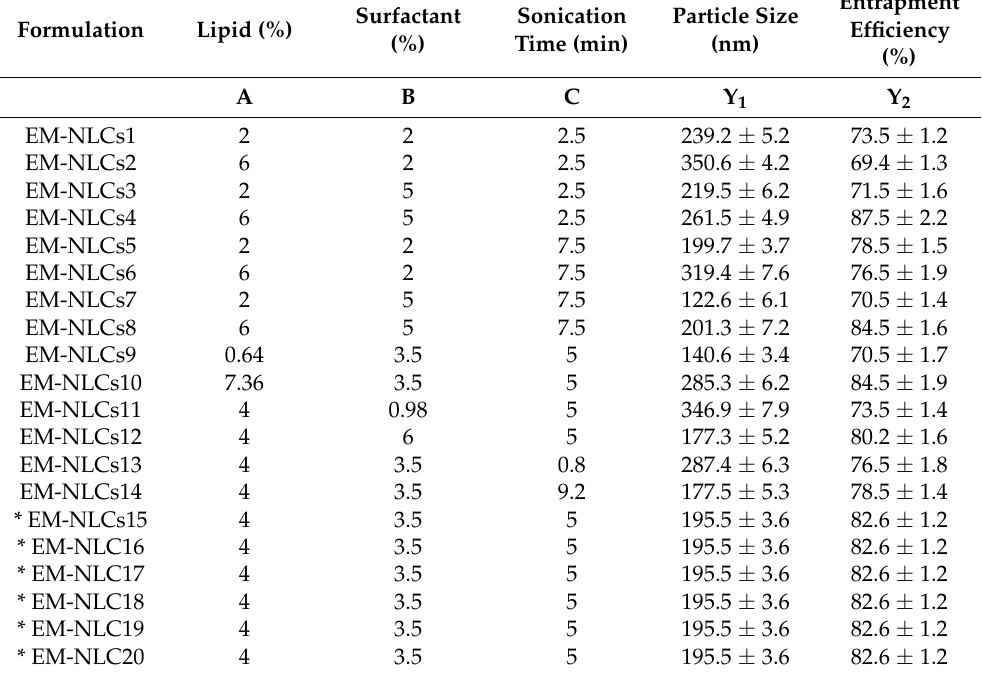
Table 2. Composition of various batches and their predicted values obtained from central composite design along with their experimental values of